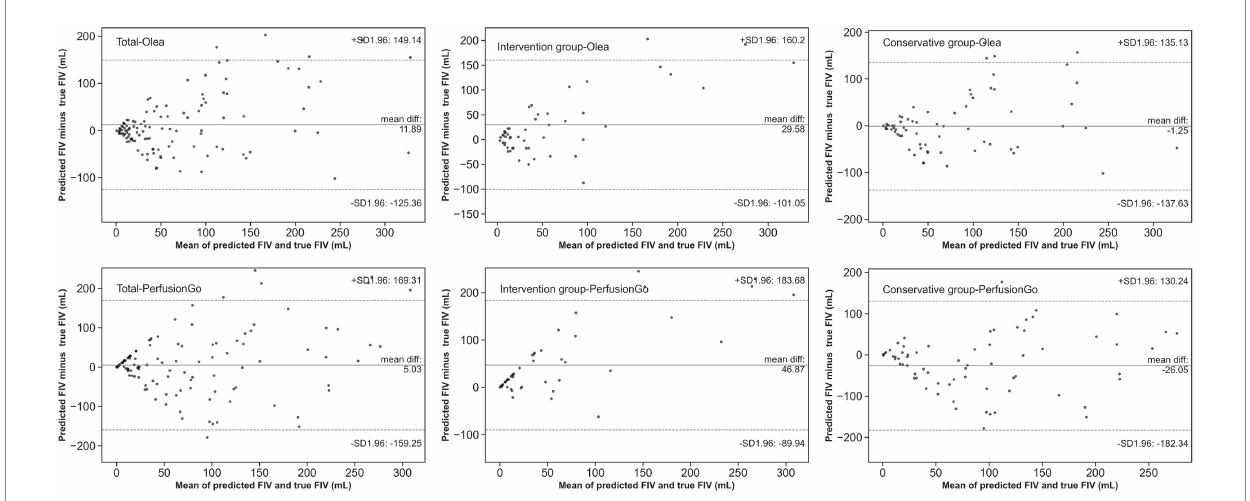
FIGURE 4 Agreement between true final infarct volume (FIV) and predicted FIV of Olea/PerfusionGo. Solid lines demonstrate the mean difference from FIV. Dotted lines represent 95% limits of